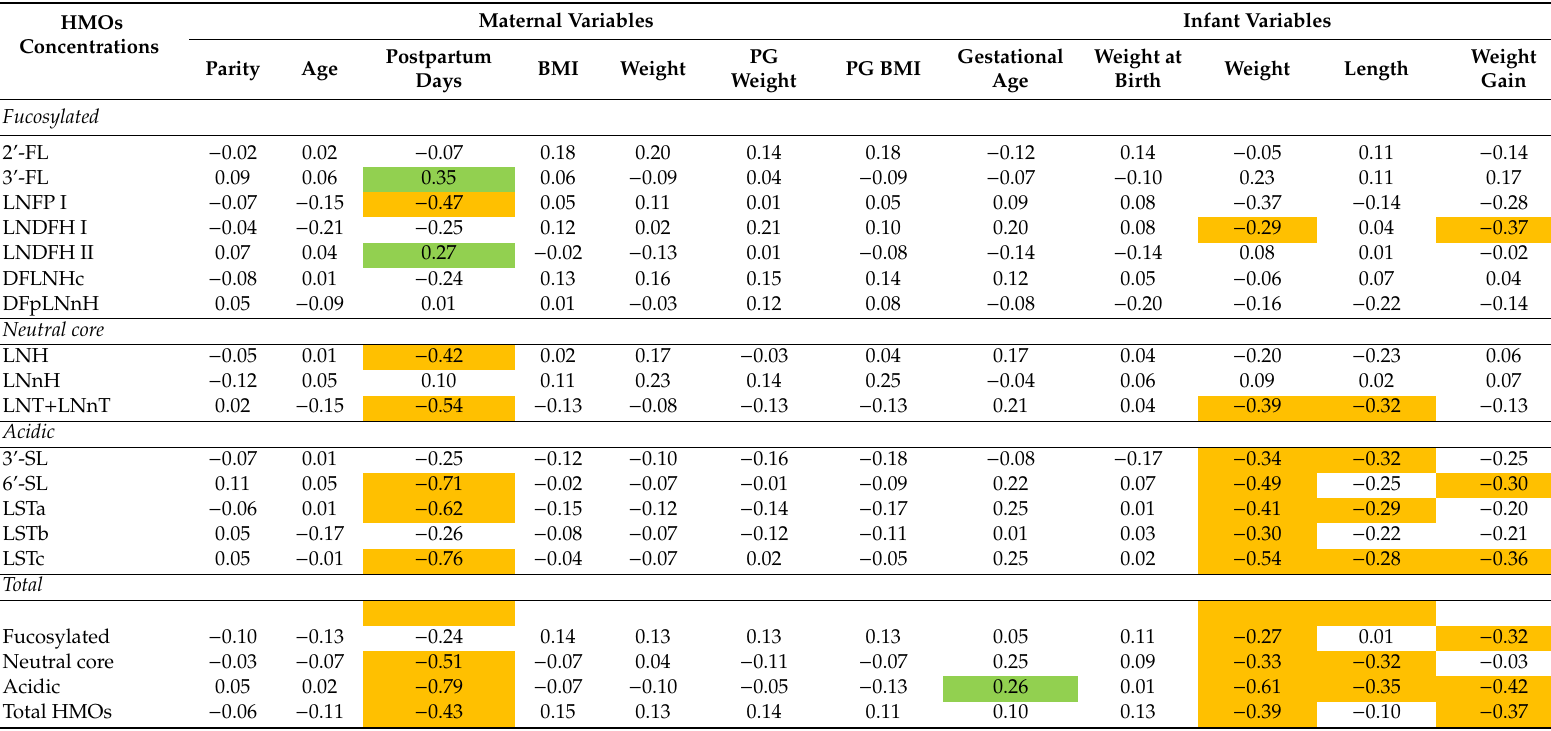
Table 5. Spearman rank correlation coe ffi cient (r) between HMOs concentrations and quantitative clinical variables in Group 1 (Se + Le + ; n = 59). Maternal Variables Infant HMOs Concentrations